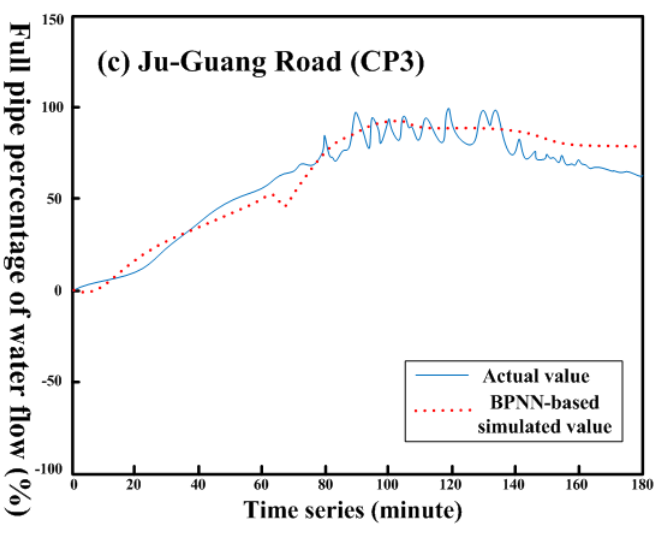
Figure 11. Unsteady continuous simulated results of Case 4 during the “12 August 2012 Flood Event” using BPNN-based